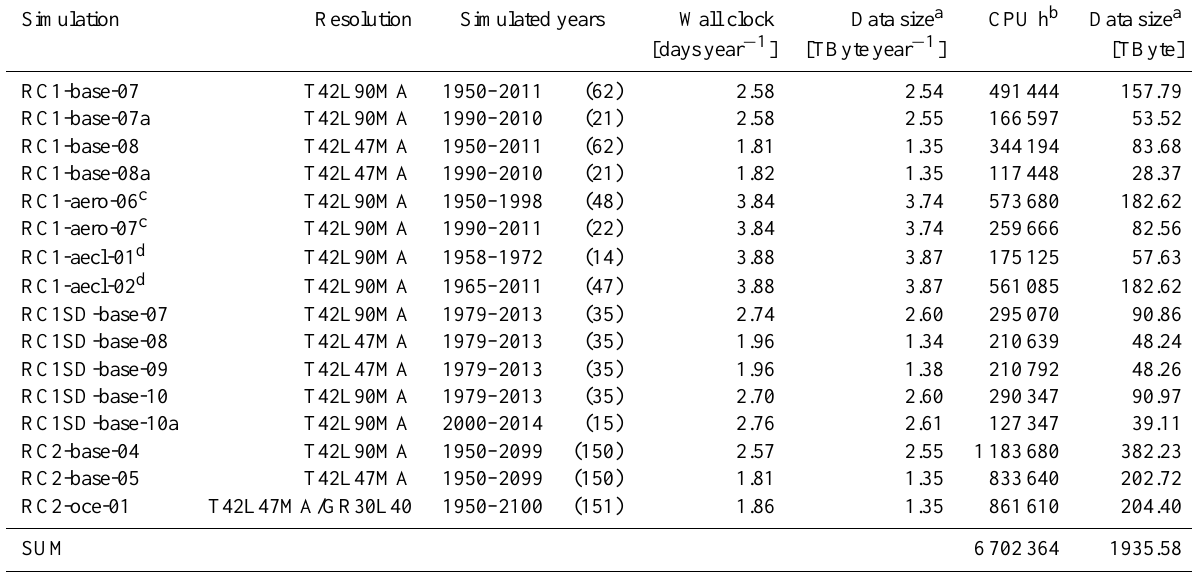
Table 2. Used computational resources and size of simulated data Simulation